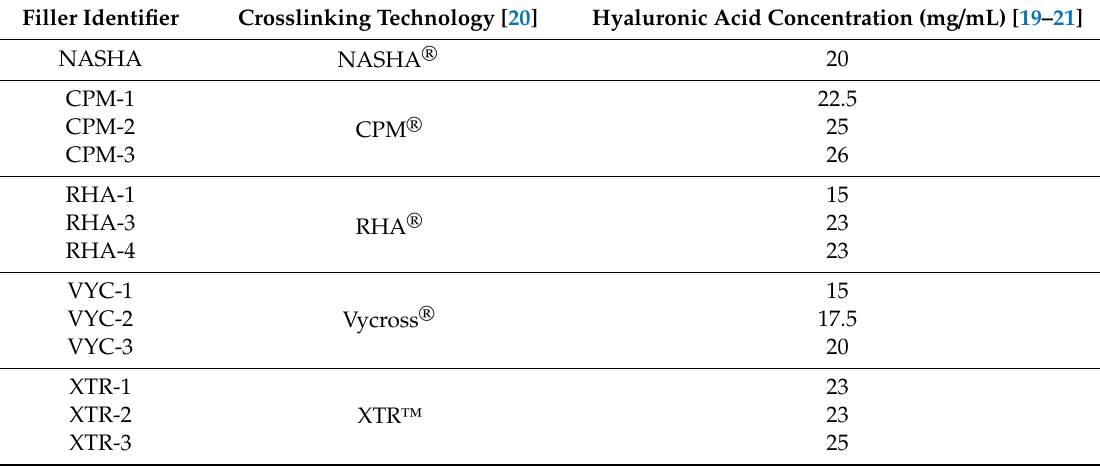
Table 1. Hyaluronic acid (HA) gel fillers analyzed for biophysical properties. Filler